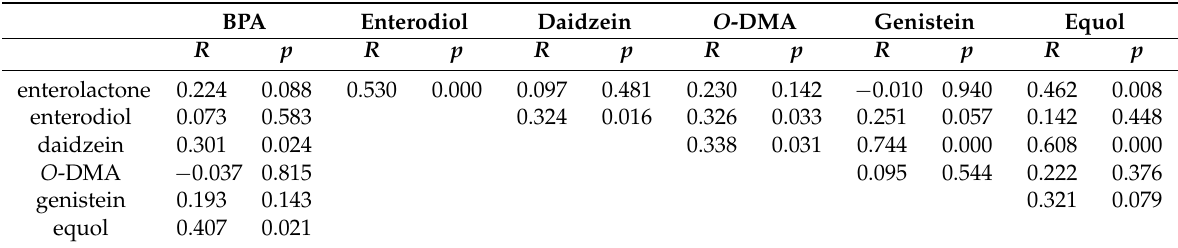
Figure 2. GM concentration of urinary phytoestrogens in children from China and the U.S. U.S. data from reference [1]. Data of the U.S. children comes from reference 1. Table 2. Results of Spearman’s correlation analysis between